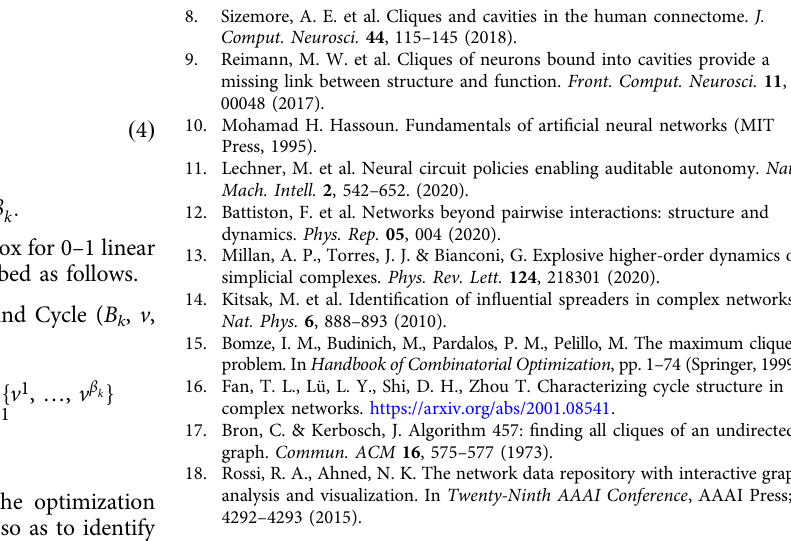
g ¼ Find Cavity